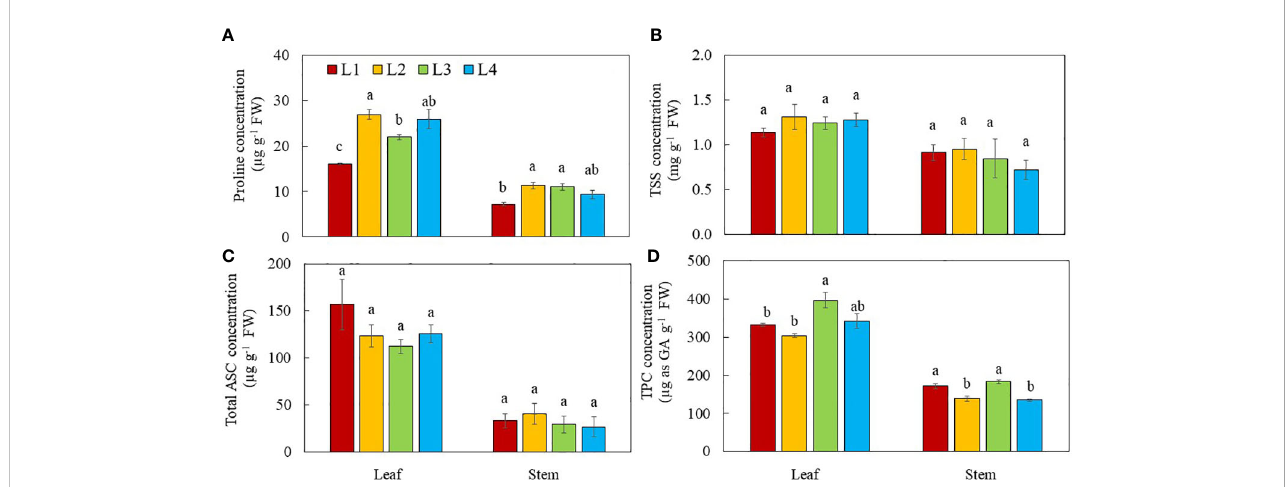
FIGURE 9 Proline (A) , TSS (B) , total ASC (C) and TPC (D) of purslane grown under different light conditions for 14 days. Values are means ± standard errors. Means with different letters are statistically different ( p <0.05; n =4) as determined by Tukey ’ s multiple comparison test for each plant organ. Refer to Figure 1 for the different conditions of L1, L2, L3 and